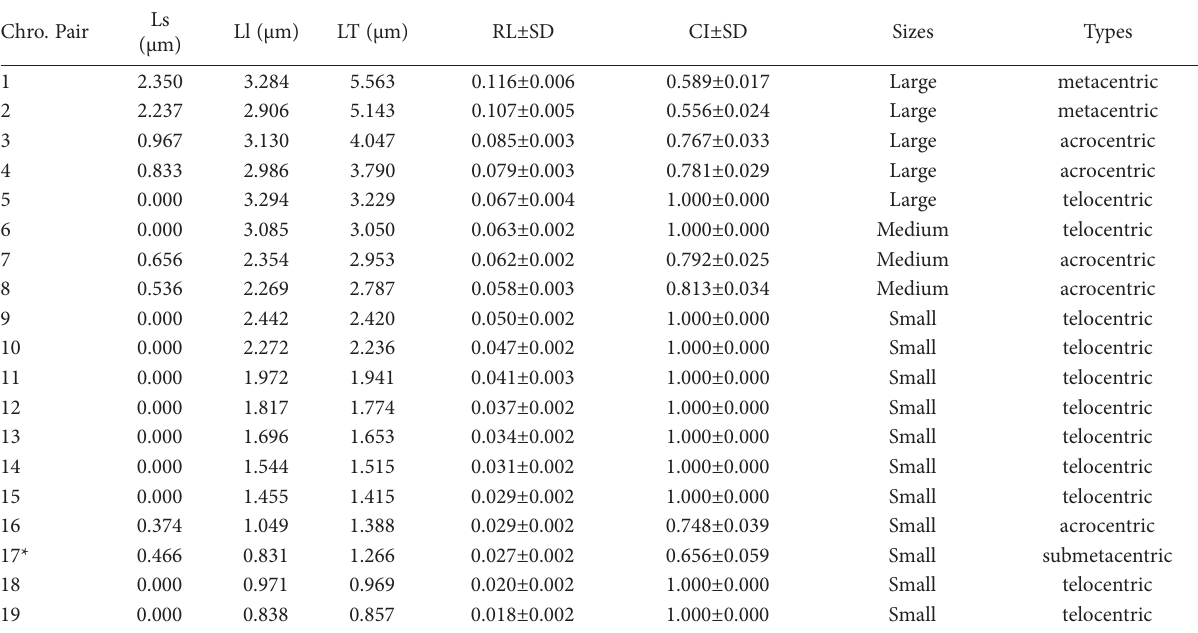
Table 2. Karyomorphological details of the G. petricolus, 2n = 38. Chro.